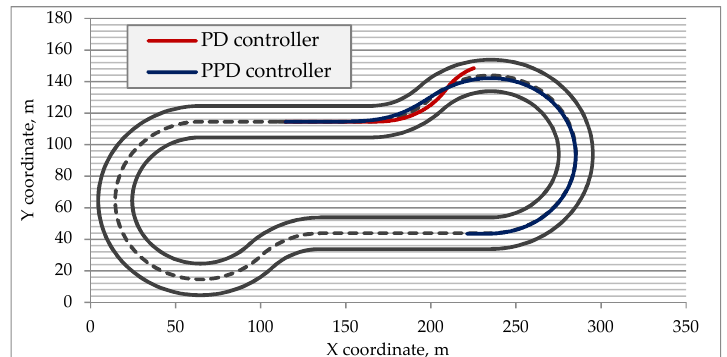
Figure 11. Car trajectory on the track tuned with prediction SAF of standard PD controller for friction coefficient µ = 0.1 with target speed equal to 1.05 V CR . The blue curve corresponds to the trajectory controlled by PPD controller, and red to the original PD controller. Table 7. Distance to the obstacle for each parameter combination, meter.